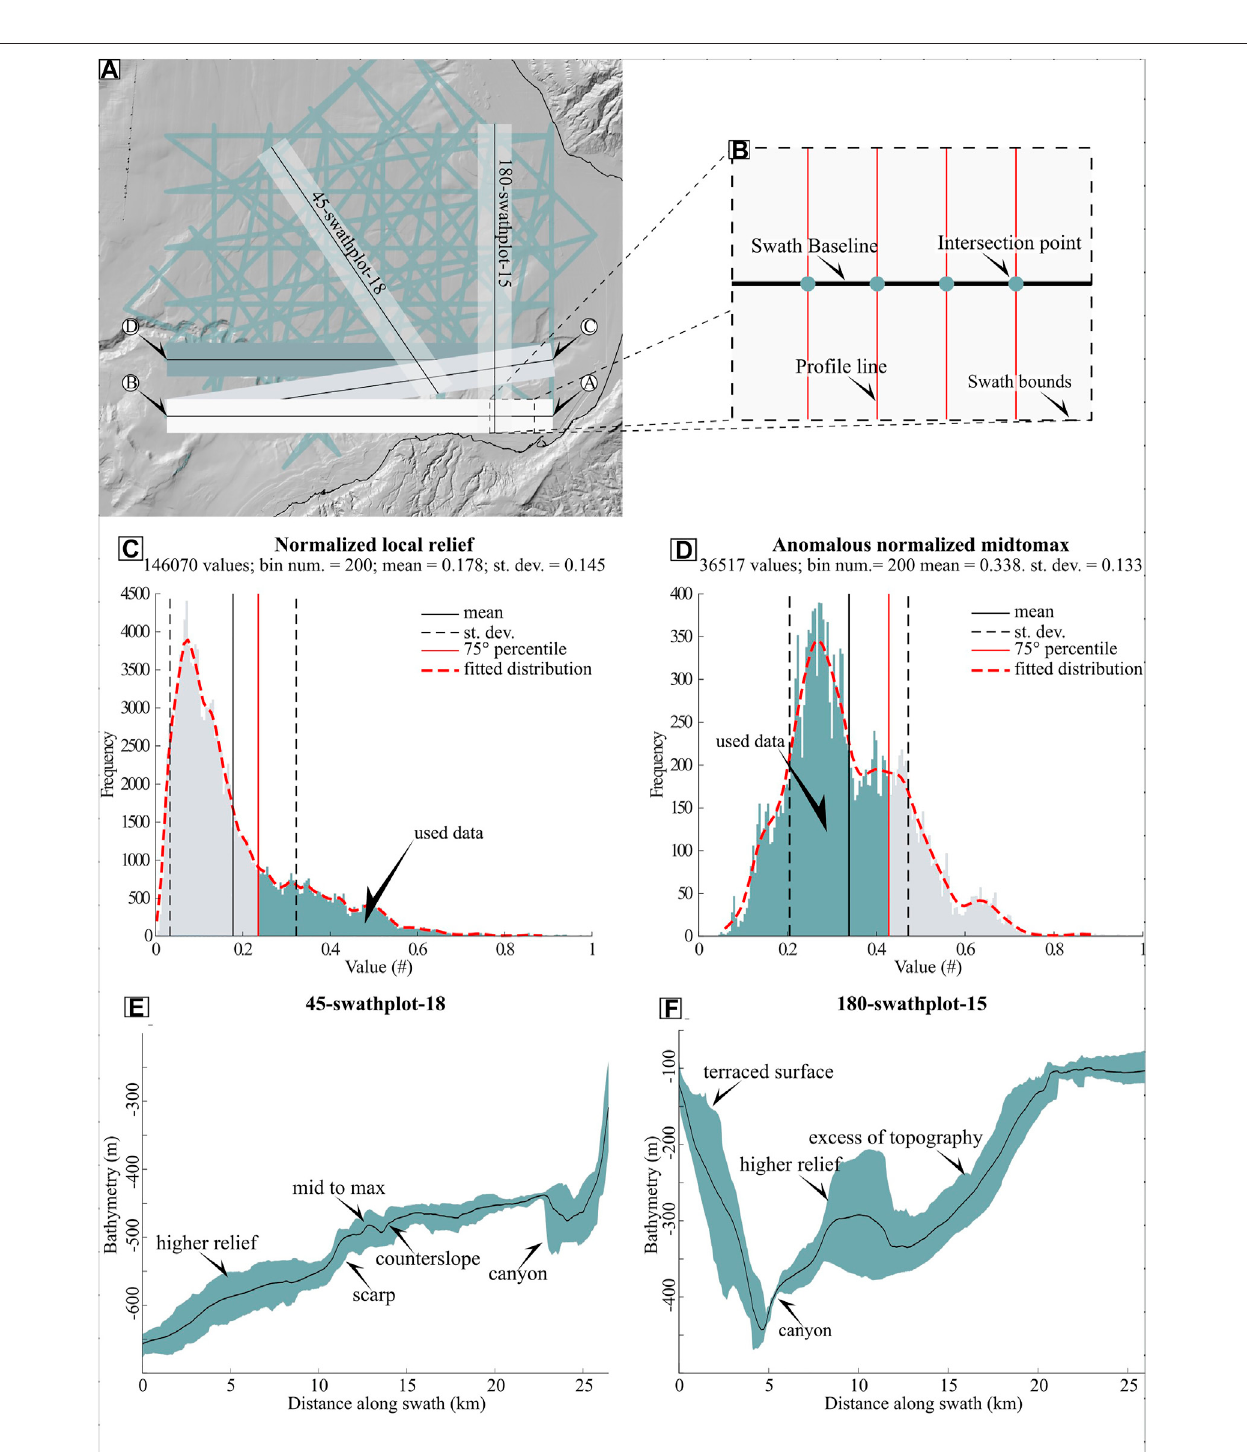
FIGURE 2 | A) Mapviewoftheswathpro fi legridusedforthesea fl oormorphometricanalyses.Thetwoswathpro fi leslabelled “ 45-swathplot-18 ” and “ 180-swathplot-15 ” , shownin (CandD) ,respectively,arehighlightedwiththewhitetransparentband.Capitalletters,fromAtoD,intowhitecircles,representtheedgesoftheswathpro fi lesegmentsin white,lightgrey,andlightgreen. (B) Conceptualsketchrepresentingthezoomoftheinitialportionofthewhiteswathpro fi leofthepreviousinset.Thethickblacklinerepresentsthe swathpro fi lebaseline,thedashedblacklinerepresentstheswathpro fi lebounds,andthethinredlinesrepresentthetopographicpro fi lelines.Thelightgreencirclesrepresent theintersectionpointsbetweenthepro fi lelinesandbaseline. (C) Frequencyhistogramofthenormalisedlocalreliefdatadistribution.Valueshigherthanthe75%percentile,inlight green,representthehighestcomputedlocalreliefvalues. (D) Frequencyhistogramoftheanomalousnormalisedmid-to-maxdatadistribution.Valueslowerthanthe75%percentile relatetoareaswherethemeanbathymetrysigni fi cantlyapproacheshigherbathymetryvalues. (E) Swathpro fi lelabelled45-swathplot-18highlightingthepresenceofascarpanda counter-slopeareaintheGulfcentralsector. (F) Swathpro fi lelabelled180-swathplot-15evidencingasigni fi